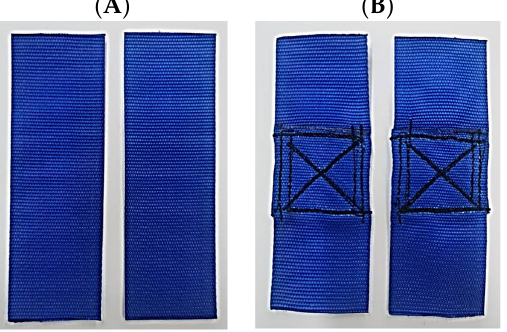
Figure 5. TS501_50 stylon belts: ( A ) without seams; ( B ) straight, longitudinal cross stitch; Source: Own research (2021).